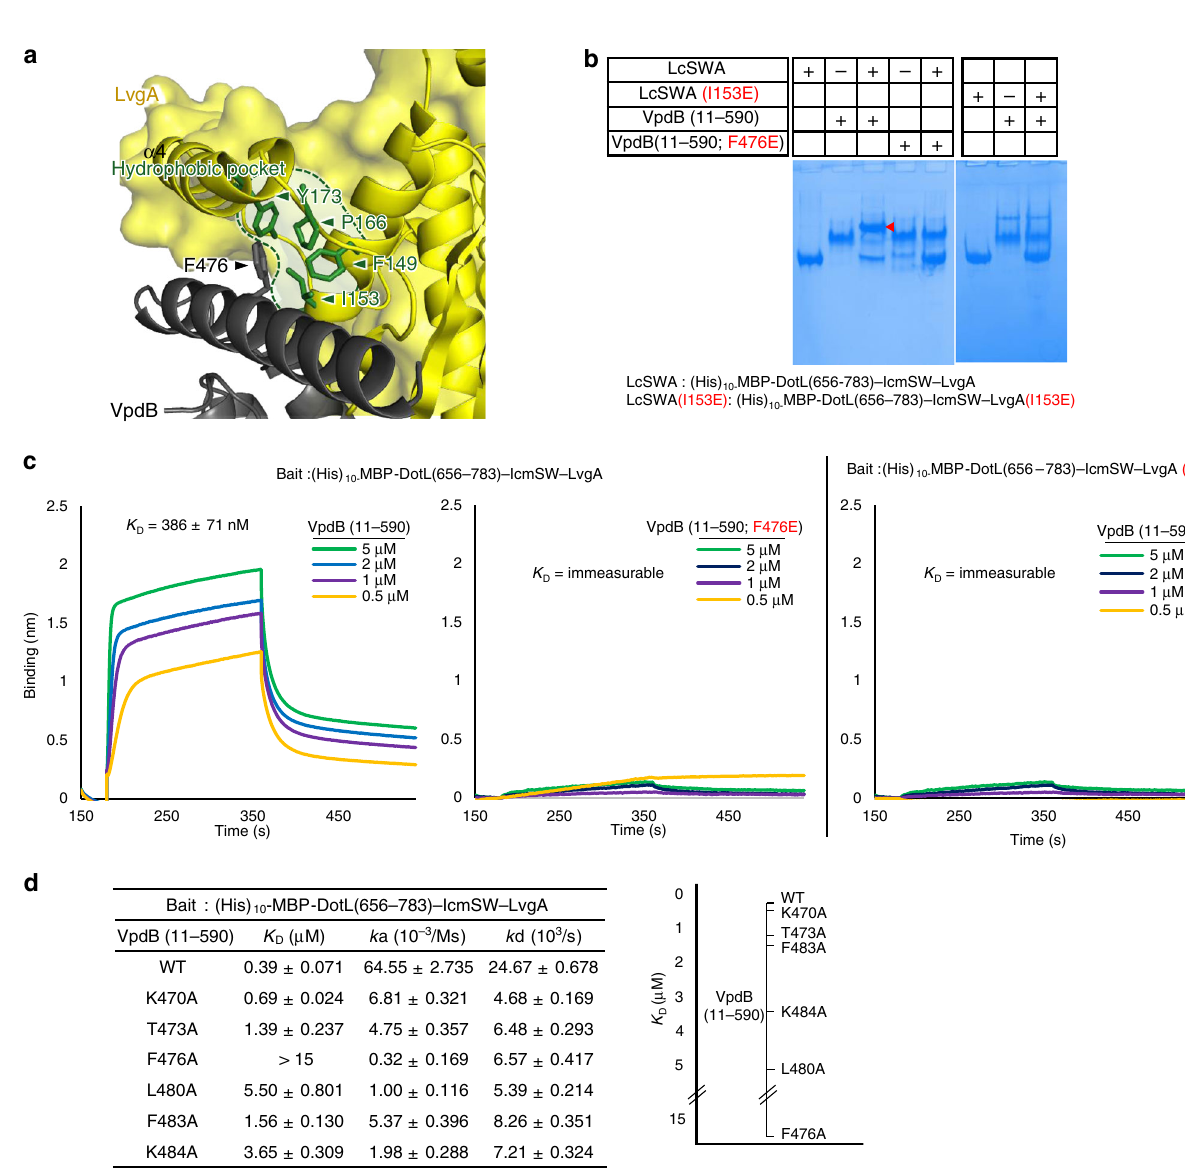
Fig. 2 Interaction between α 1 of VpdB(461-590) and the LvgA subunit. a A prominent hydrophobic interaction. Phe476 of VpdB packs against a hydrophobic pocket on LvgA indicated by the dotted line. Four residues that constitute the hydrophobic pocket are shown as sticks. b Native PAGE analysis. The VpdB(F476E) or LvgA(I153E) mutation disrupted the interaction between VpdB(11-590) and (His) 10 -MBP-DotL(656-783) – IcmSW – LvgA. c Quanti fi cation. The binding af fi nity between (His) 10 -MBP-DotL(656-783) – IcmSW – LvgA and VpdB(11-590) was drastically decreased by either VpdB (F476E) or LvgA(I153E) mutation. The interaction was measured by bio-layer interferometry, where the indicated bait was immobilized on a Ni-NTA biosensor via the N-terminal (His) 10 -MBP tag fused to DotL(656-783). The measurement was triplicated. d Alanine mutagenesis. Binding af fi nities between (His) 10 -MBP-DotL(656-783) – IcmSW – LvgA and VpdB(11-590) variants containing the indicated alanine substitution were analyzed by bio-layer interferometry. A plot of the measured K D values is shown on the right. Quanti fi cation was duplicated for each